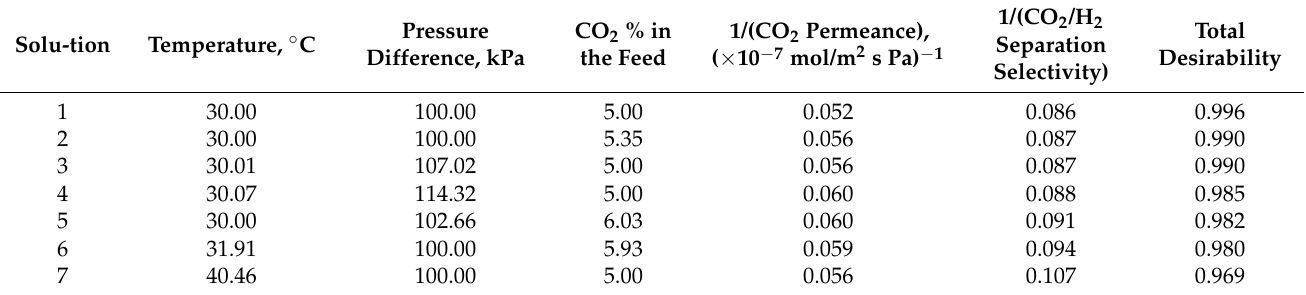
Table 6. Optimum conditions for the 1/(CO 2 /H 2 separation selectivity) and the 1/(CO 2 permeance) generated by Design